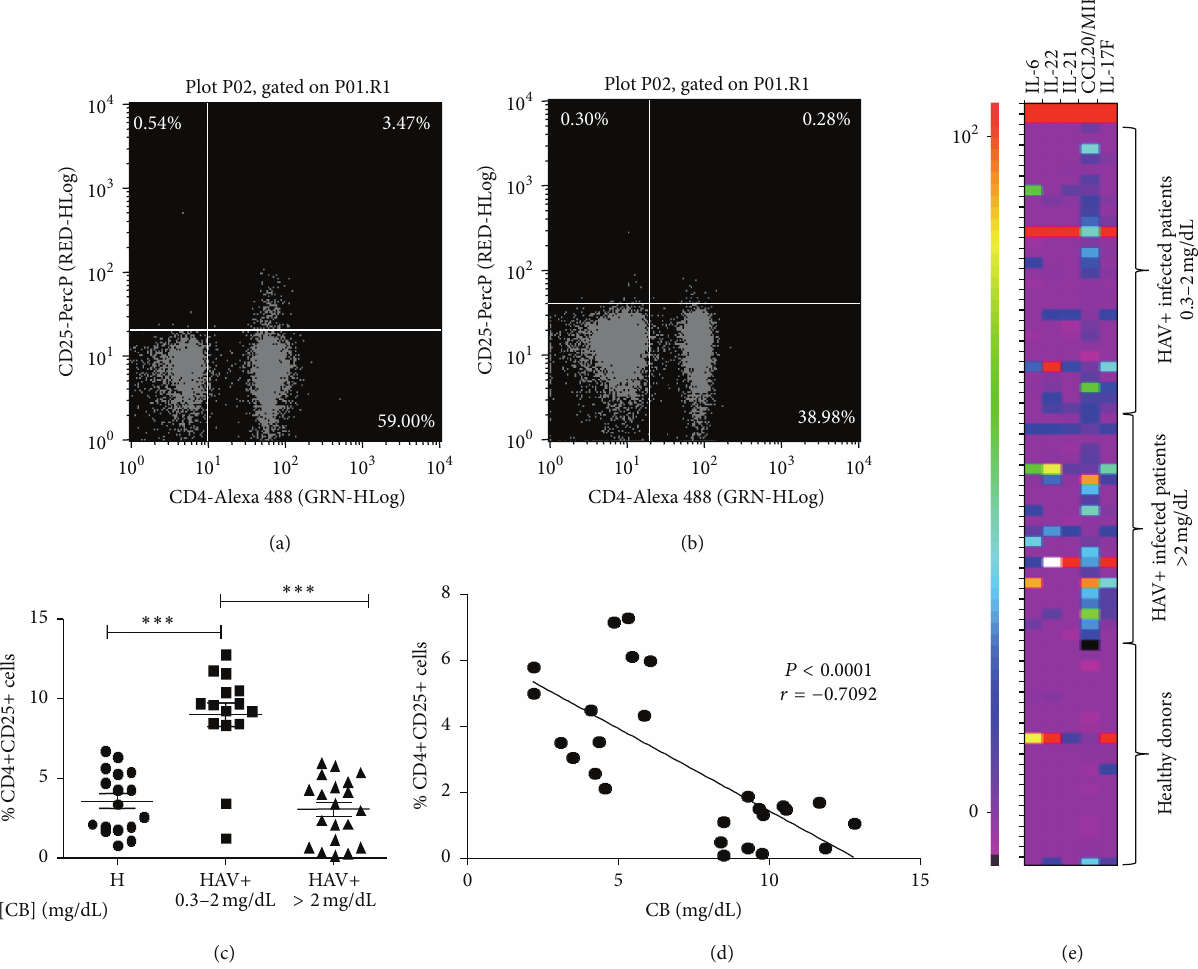
Figure 3: HAV-seropositive patients with low CB levels show an increase in the percentage of CD4+CD25+ TLs. PBLCs were separated from patients and controls. Cells were stained with anti-CD4-Alexa 488 and anti-CD25-PercP and then analyzed by using flow cytometry. Representative dot plot from (a) HAV+ patients with CB 0.3–2 mg/dL and (b) HAV+ patients with CB greater than 2mg/dL are shown. (c) The results are displayed as the percentage of double positive cells for CD4 and CD25. The medians and the SD from 17 healthy donors, 17 patients with CB 0.3–2 mg/dL, and 15 patients with CB greater than 2mg/dL are presented. Nonparametric Kruskal-Wallis for comparison between groups was used to calculate statistical significance. 𝑃 < 0.05 was considered statistically significant. ∗∗∗ 𝑃 < 0.0001 . The Spearman correlation coefficient for the percentage of CD4+CD25+ T cells and the CB levels in HAV+ patients was calculated in (d). (e) Th17 cytokines were evaluated in serum from patients with CB 0.3–2 mg/dL ( 𝑛 = 44 ), patients with CB greater than 2 mg/dL ( 𝑛 = 45 ) and healthy donors ( 𝑛 = 40 ) by MAGPIX Technology. Representative Heat map (pg/mL) of 40 controls and 71 patients is shown.